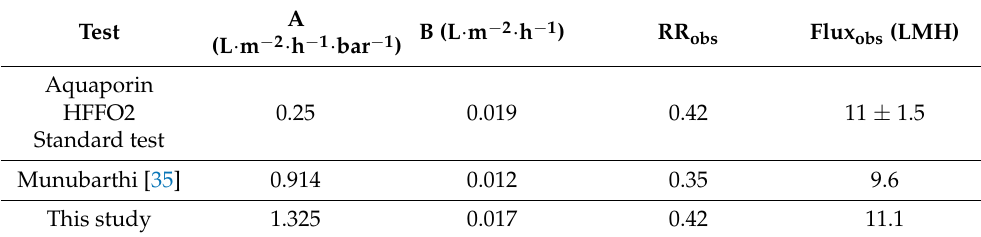
Table 2. Comparison of standard test and simulation for different sets of parameters.